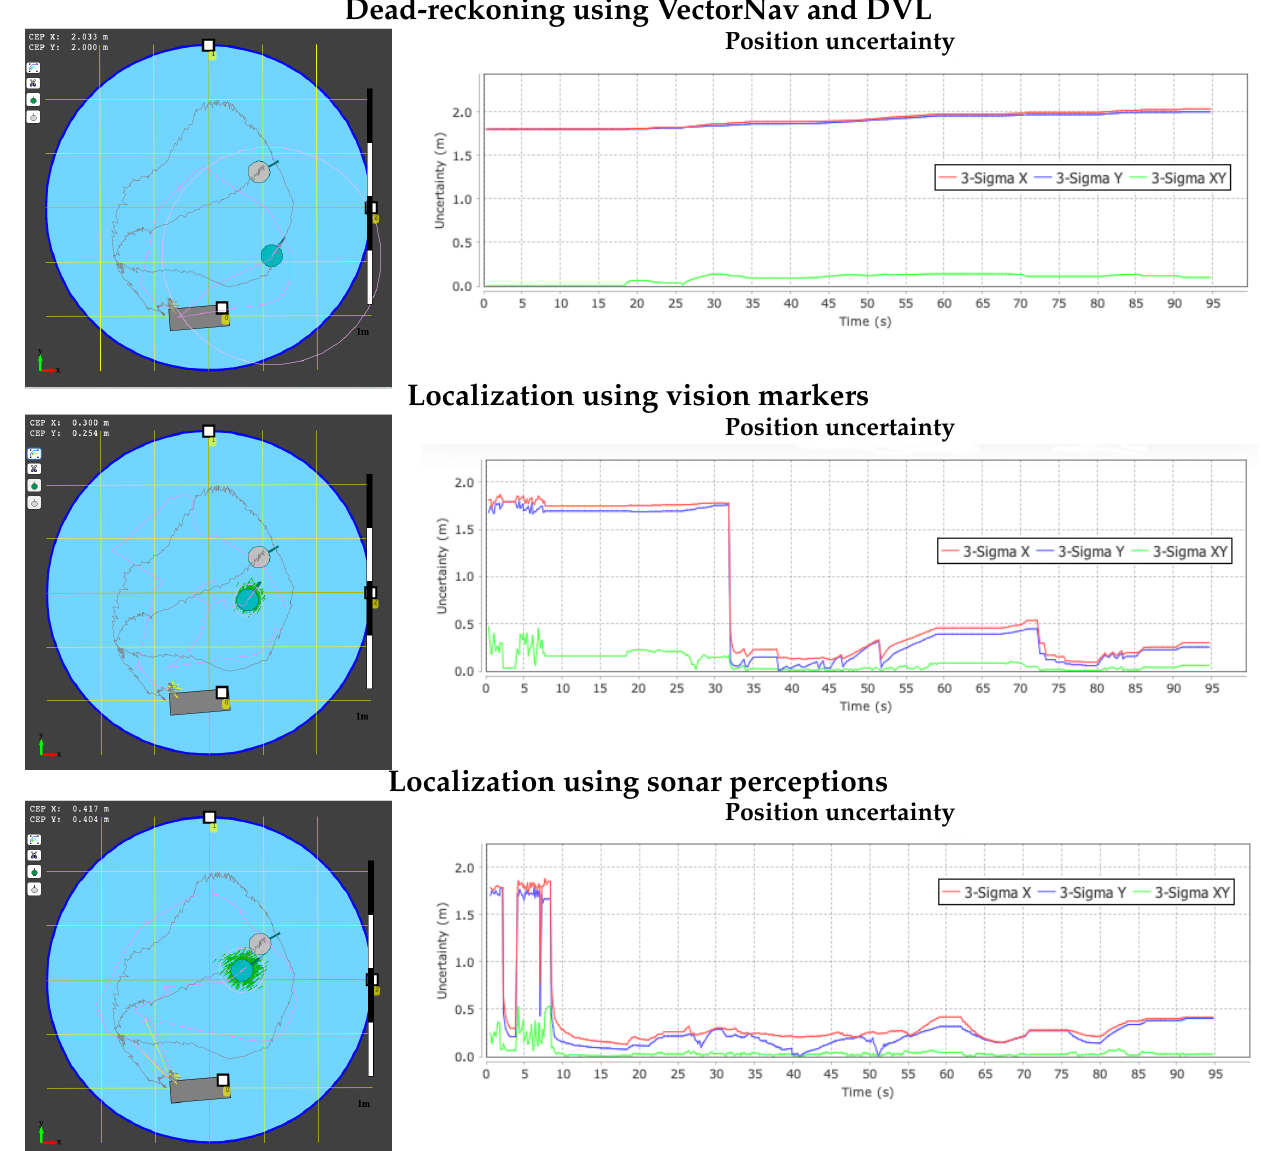
Figure 13. Position estimation uncertainty using ( top ) dead-reckoning, ( middle ) vision markers, and ( bottom ) sonar perceptions in the structured swimming pool